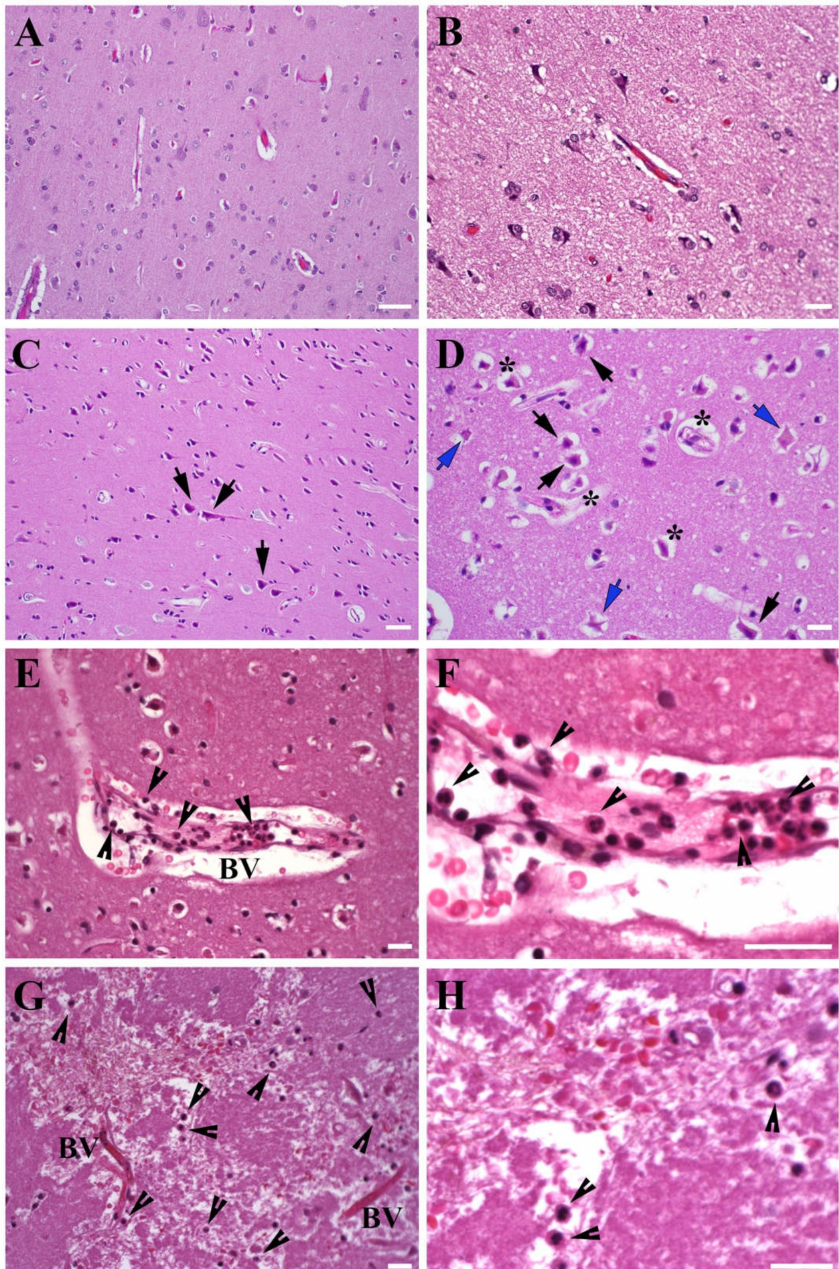
Figure 2. Morphology of human stroke brain tissue. Morphological evaluation of the temporal lobe tissue, HE staining. ( A , B ), Control non-stroke samples; ( C , D ), Brain tissue collected at 48 h after stroke onset. Black arrows: eosinophilic (red) neurons with darkly stained pyknotic nuclei. Blue arrows: necrotic “ghost” neurons with an absent nuclear detail. Stars: peri-neuronal and peri-vascular space widening associated with edema. Neutrophils (arrowheads) were detected in the vicinity of large vessels and capillaries ( E , F ), tissue collected at 60 h after stroke onset), as well as in the brain parenchyma ( G , H ), tissue collected at 28 h after stroke onset). ( E ) and higher magnification in ( F ): Margination and pavementing of neutrophils along the blood vessel wall; some neutrophils migrated out and are detected in the blood vessel vicinity. ( G ) and higher magnification in ( H ): Neutrophils are detected at a considerable distance from the blood vessels, which demonstrates the process of neutrophil invasion into the damaged brain tissue. BV- blood vessel. Bars: ( A , C ): 50 µ m; ( B , D , E – H ): 20 µ